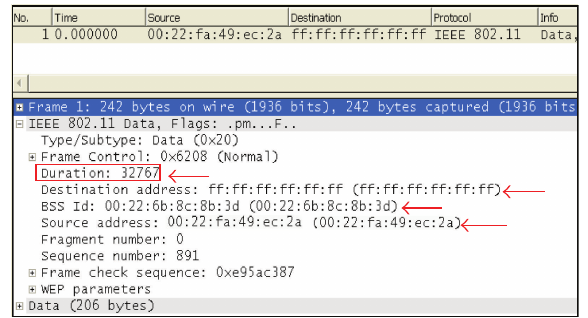
Figure 9: The encrypted modified data frame chosen for replay.